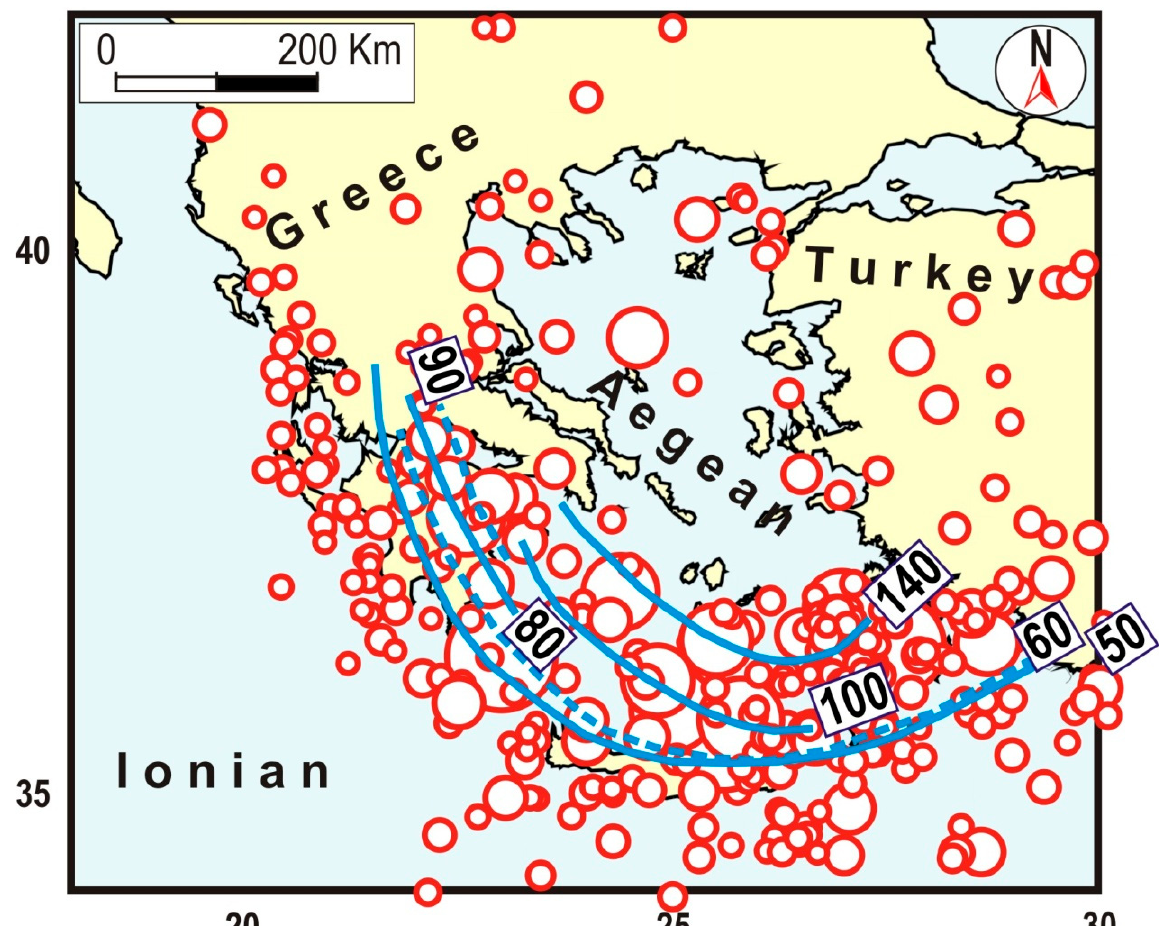
Figure 4. Distribution of subcrustal earthquakes (h > 30) and tentative reconstruction of the Hellenic slab (isodepth lines from [46] and references therein).